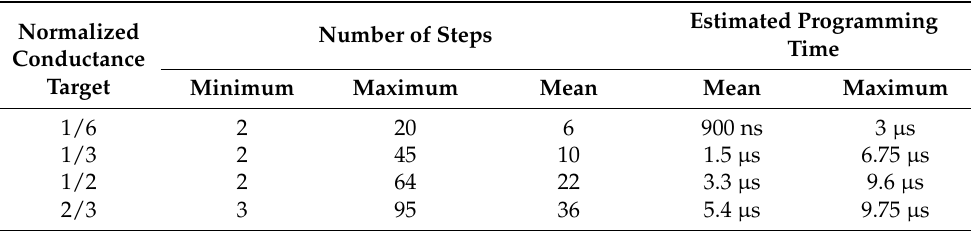
Table 2. Required number of steps for cells programming and estimated programming times.